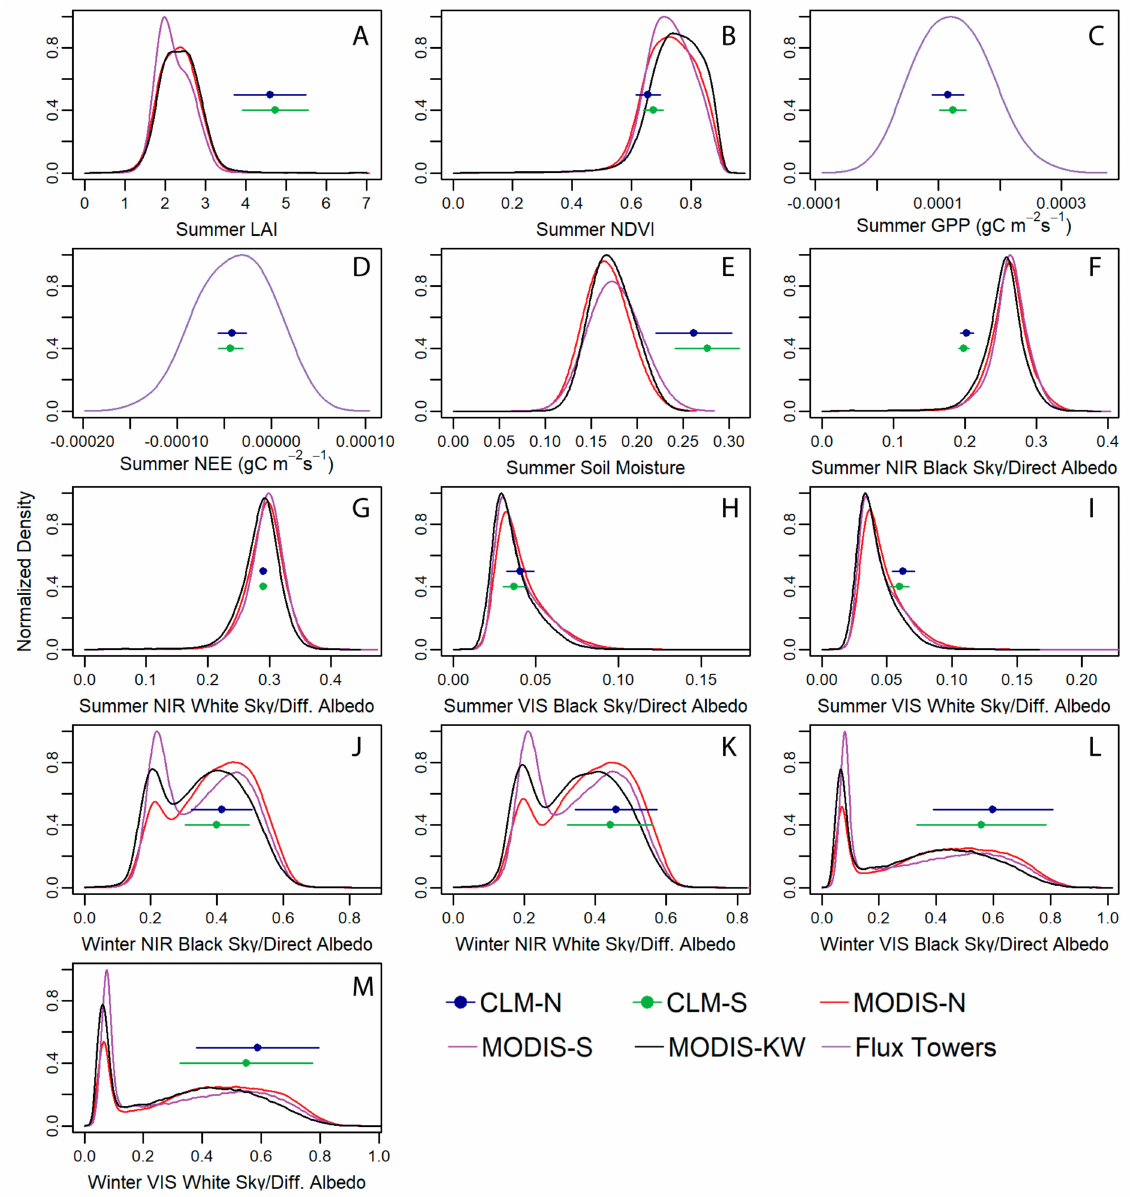
Figure 9. Normalized probability density functions for summer (June, July, August, A – I ) or winter (December, January, February, J – M ) observations including spatial heterogeneity within the grid cell and watershed boundaries. CLM values are placed arbitrarily on the y-axis for